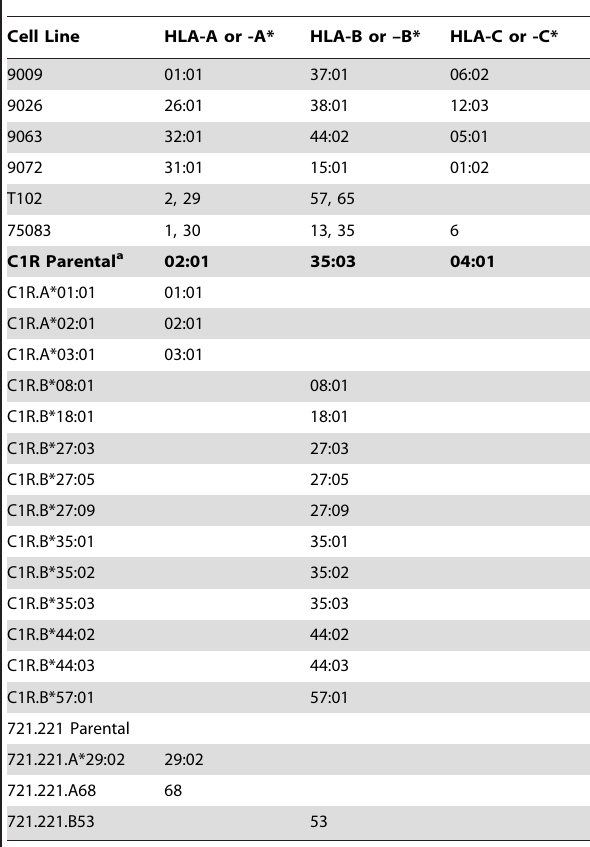
Table 3. HLA class I typing of cell lines.